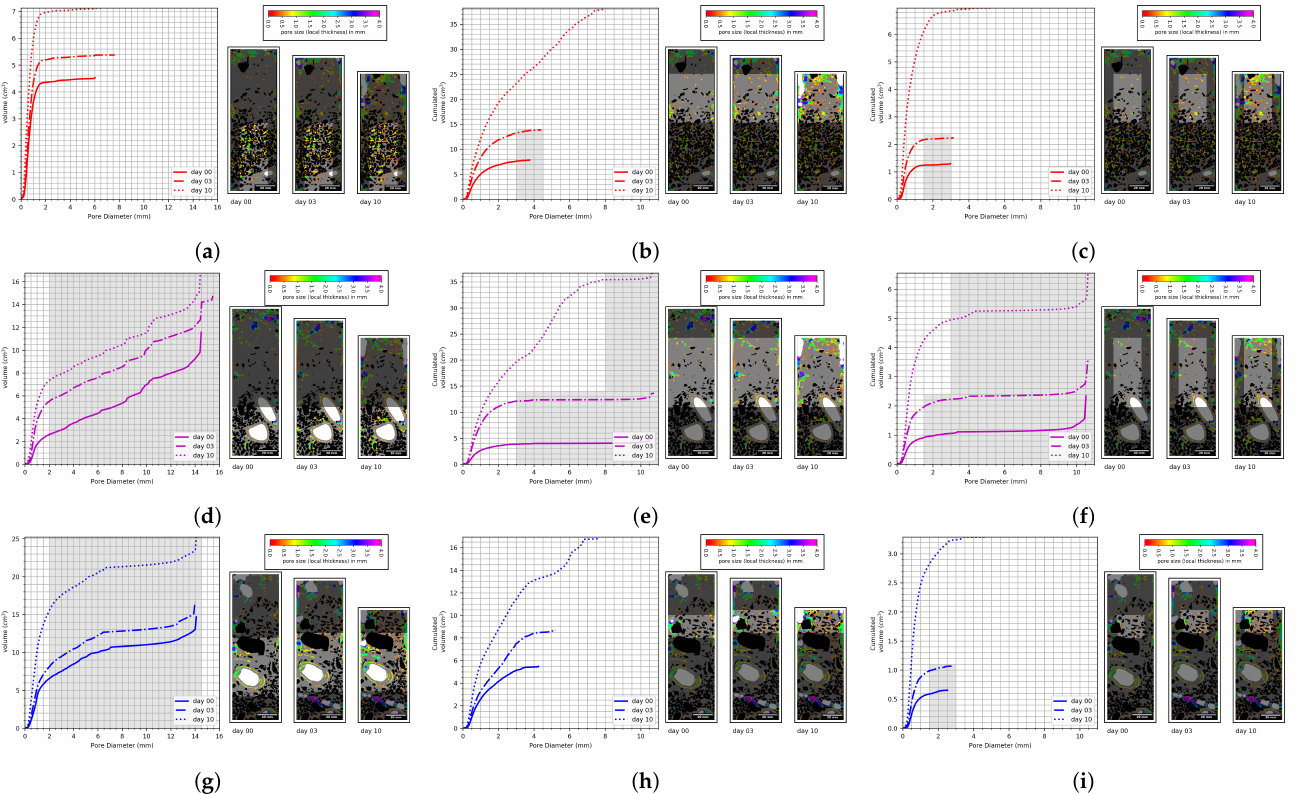
Figure 6. Cumulative Pore Size Distributions (PSD) associated to snapshots highlighting the ROI on which computation are performed (on the right). ( a ) MON1, gravel layer, ( b ) MON1, deposit layer ROI = 100%, ( c ) MON1, deposit layer ROI = 60%, ( d ) MON2, gravel layer, ( e ) MON2, deposit layer ROI = 100%, ( f ) MON 2, deposit layer ROI = 60%, ( g ) MON3, gravel layer, ( h ) MON3, deposit layer ROI = 100%, ( i ) MON3, deposit layer ROI =